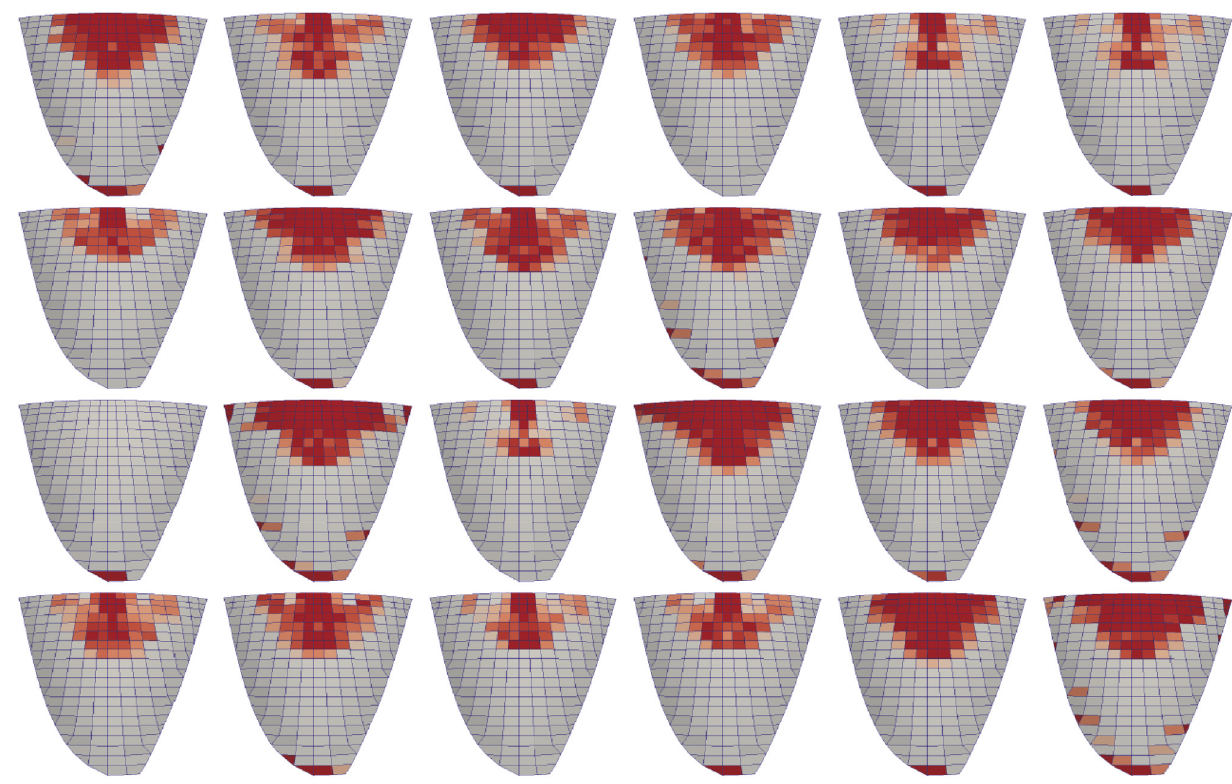
Figure 8: Distribution of first crack on upstream face; top left: Sim-1; first row: 1 to 6; bottom right: Sim-24.